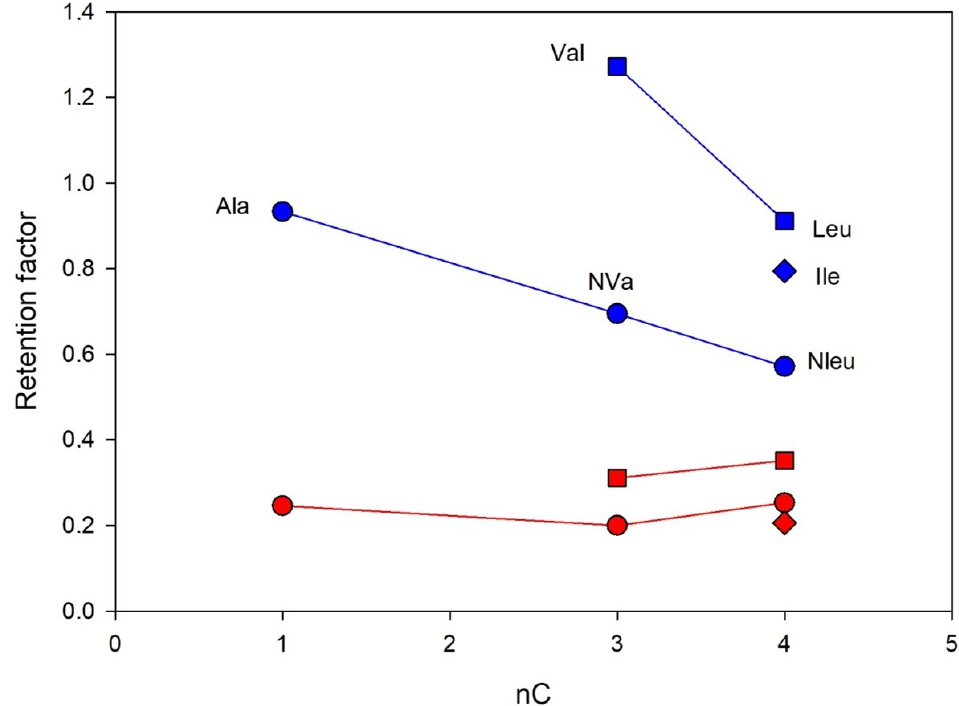
Figure 6. The retention of D- (blue lines) and L-enanatiomers (red lines) of amino acids containing alkyl groups in a side chain as a function of the number of carbon atoms. Column: Chloro-E-CSP, eluent 10% methanol and 90% of 0.1 M sodium dihydrophosphate buffer with pH